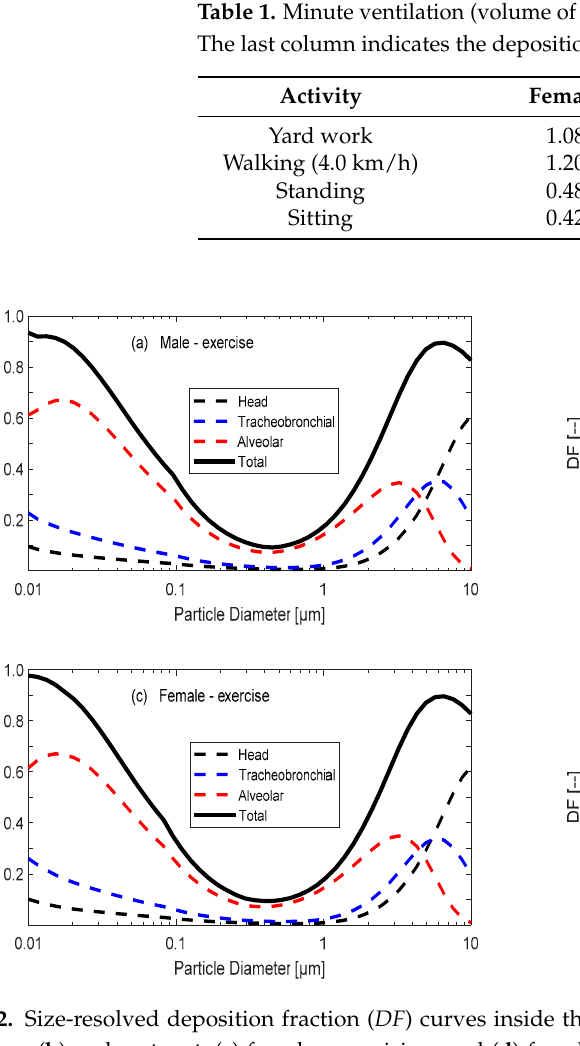
Figure 2. Size-resolved deposition fraction ( DF ) curves inside the respiratory tracts of the following adults: ( a ) males exercising, ( b ) males at rest, ( c ) females exercising, and ( d ) females at rest. Data was adopted from Löndahl et al. [35] and the International Commission on Radiological Protection (ICRP) and Multiple-Path Model of Particle Deposition (MPPD) models.